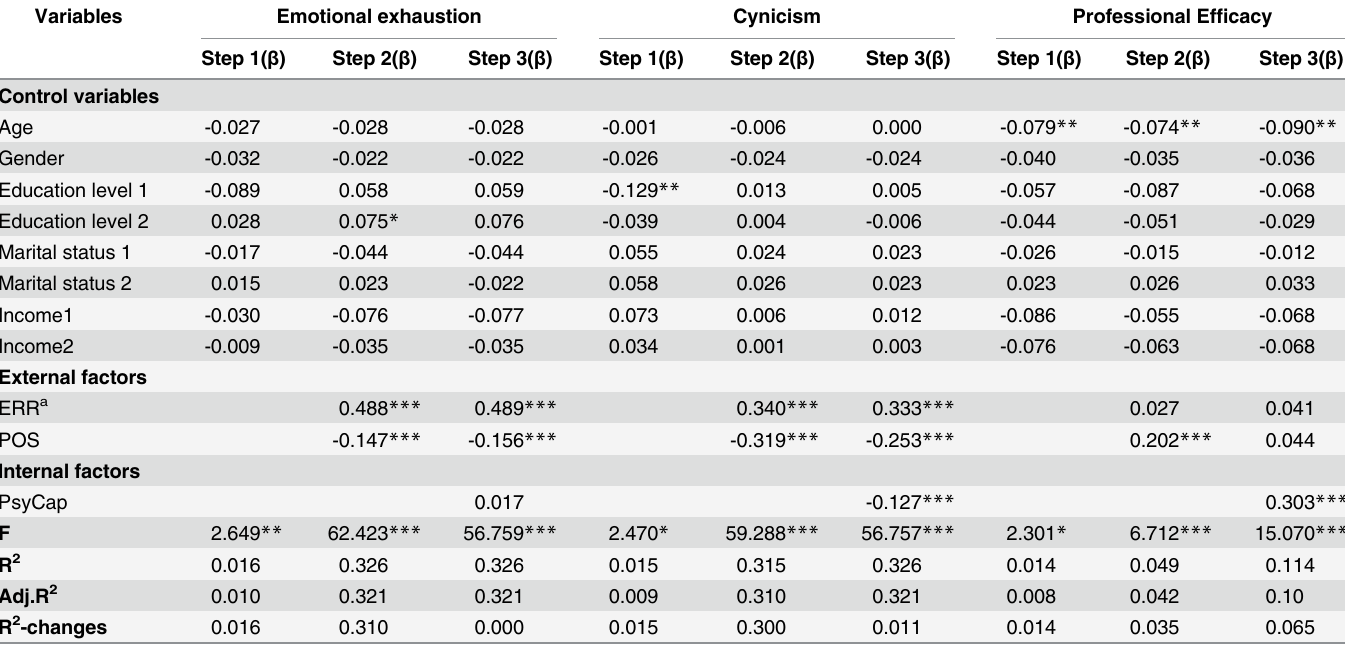
Table 3. Hierarchical regression analysis for exploring the external and internal factors on the three dimensions of